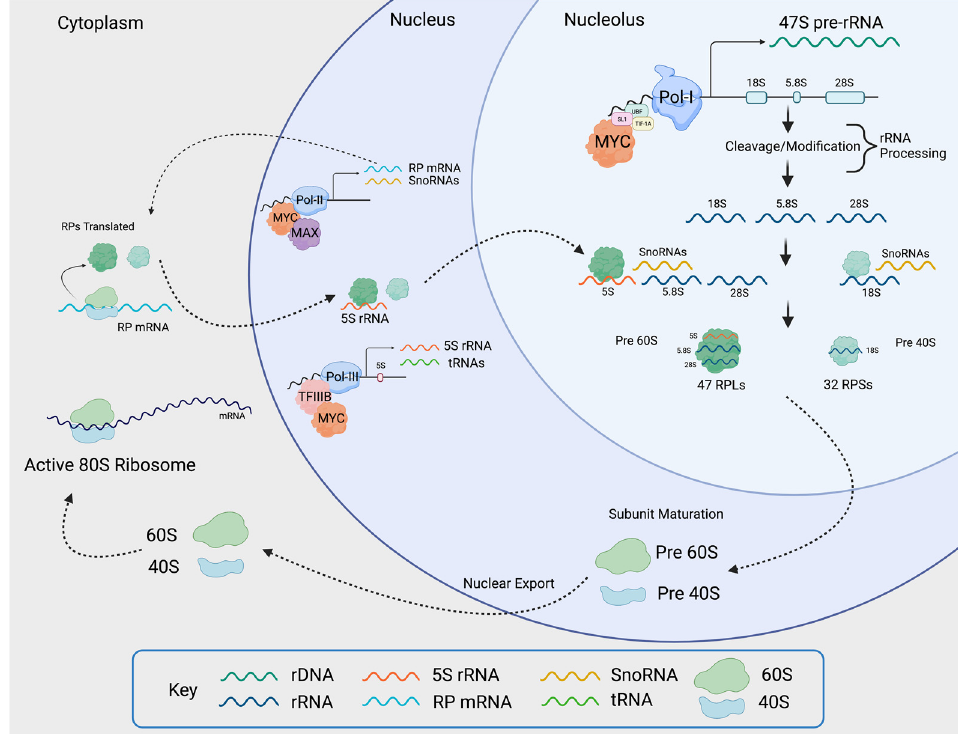
Figure 5. MYC induces ribosomal biogenesis processes. MYC heterodimerizes with MAX and promotes RNAPolI activity by binding to the rDNA promoter, as well as by activating the expression of selectivity factor 1 ( SL1 ), which binds other RNAPolI cofactors such as upstream binding factor (UBF) and TIF-1A. The rDNA is transcribed into 47S pre-rRNA in the nucleolus. The pre-rRNA is processed and cleaved into 18S, 5.8S, and 28S rRNA. MYC-MAX simultaneously enhances RNAPolII activity by binding to RNAPolII-regulated promoters, as well as RNAPolIII activity by inducing the expression of the RNAPolIII cofactor TFIIIB. This yields RNAPolII-driven small RPs (RPS) mRNA, large RPs (RPL) mRNA, RNAPolIII-driven snoRNAs, and 5S rRNA. The mRNAs are transported into the cytoplasm where mature ribosomes translate them into small and large RPs. Once translated, small RPs are imported into the nucleolus. Large RPs are first imported into the nucleus, where they interact with 5S rRNA, and then to the nucleolus. In the nucleolus, the pre-rRNAs are modified and processed with the help of snoRNAs. As they are maturing, the rRNA wrap around the RPs, creating the pre-40 and pre-60 subunits which are exported to the cytoplasm for the final maturation step. Once maturation is complete in the cytoplasm, the active 80S ribosomes are formed. The small 40S subunit comprises 18S rRNA and 32 small RPs, and the large 60S subunit comprises 5S, 5.8S, and 28S rRNA and 47 large RPs. Figure created using Biorender.com (accessed on 31 January 2022).